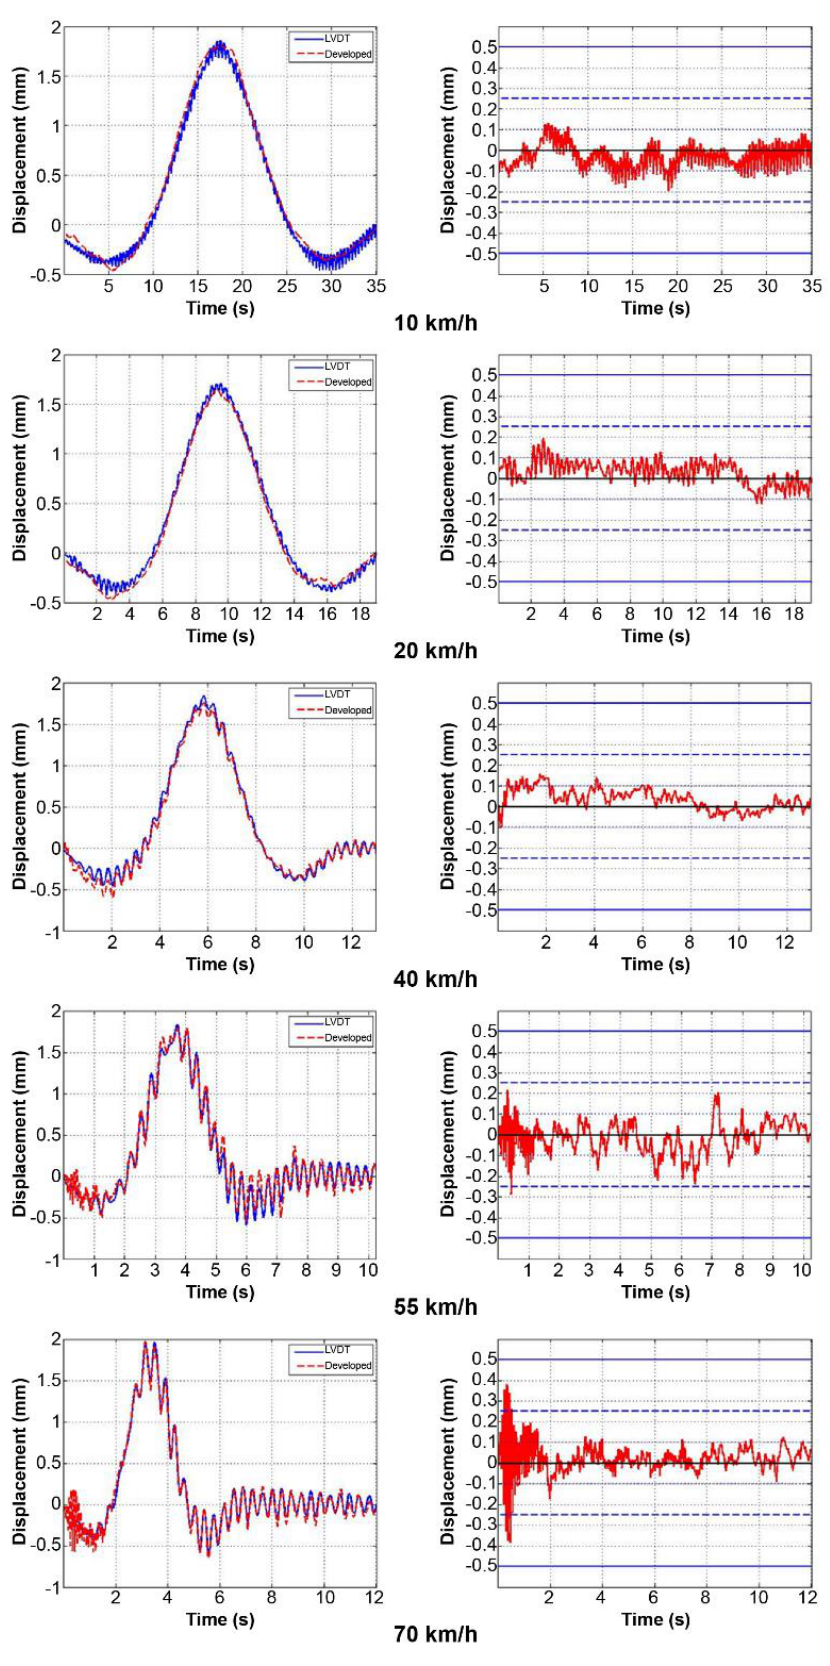
Figure 10. Signal comparison and errors of the dynamic loading test.